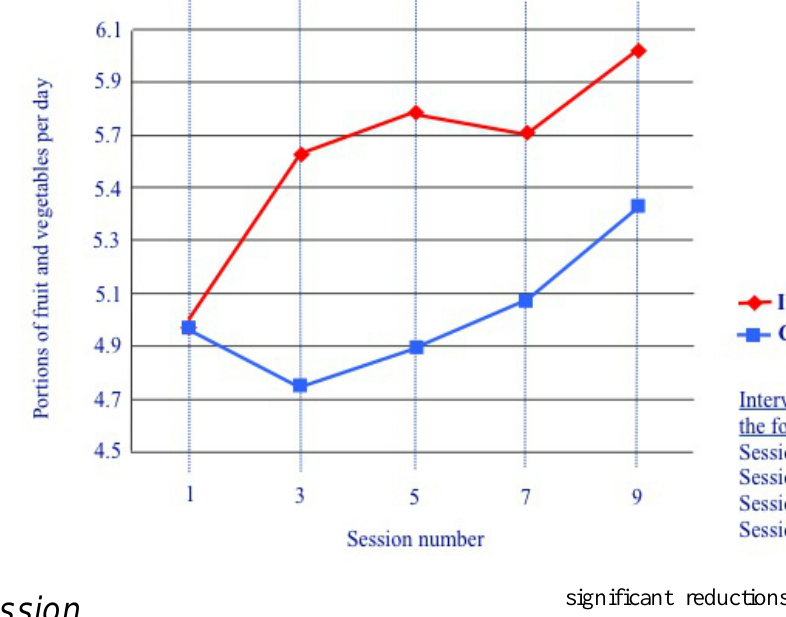
Figure 3. Portions of fruit and vegetables consumed in the intervention and control groups during the motivational